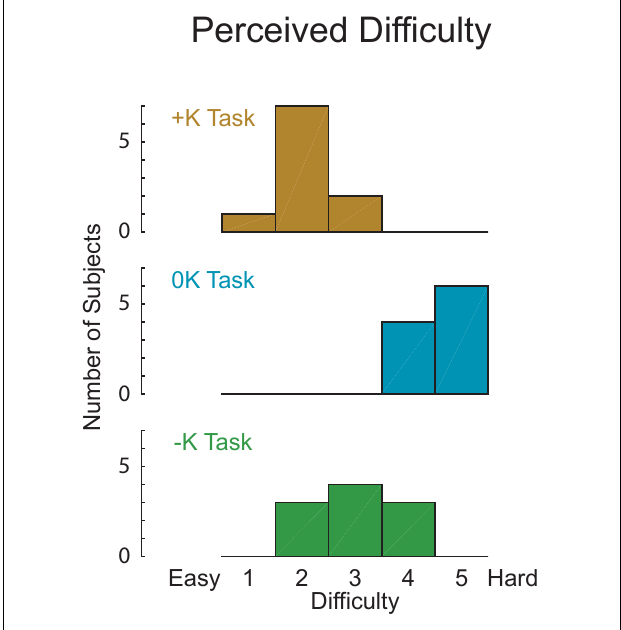
FIGURE 8 | The +K task was perceived to be easier by the subjects, as rated on a 1–5 difficulty scale.